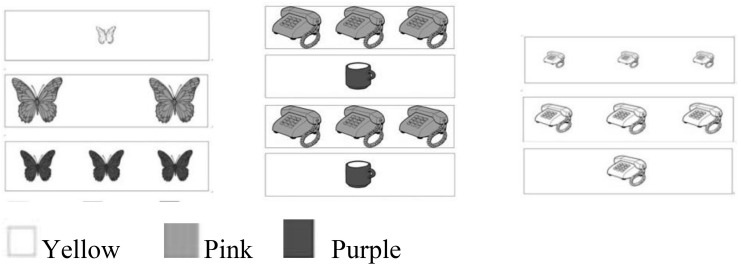
Examples of Demonstration (left), Criteria (center), and Test (right) trial cards from the Flexible Item Selection Task, adapted from a test of cognitive flexibility (Jacques and Zelazo, 2001).